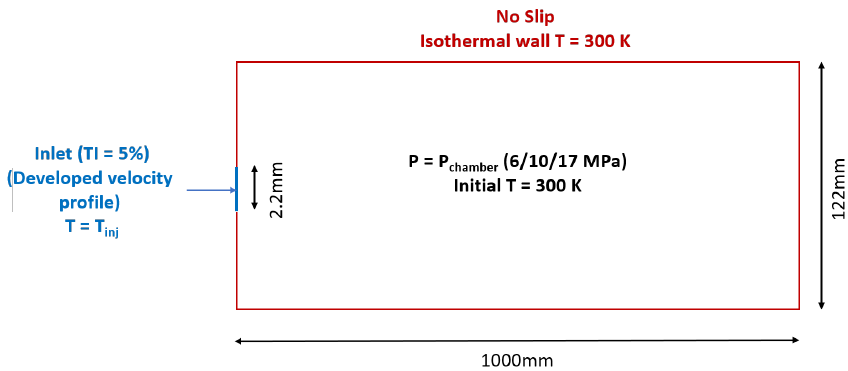
Figure 13. Boundary conditions implemented in mesh 1 to obtain a fully developed velocity profile at the end of the injector.